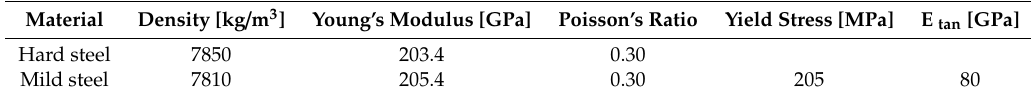
Table 3. Properties of the core and the solid plate,